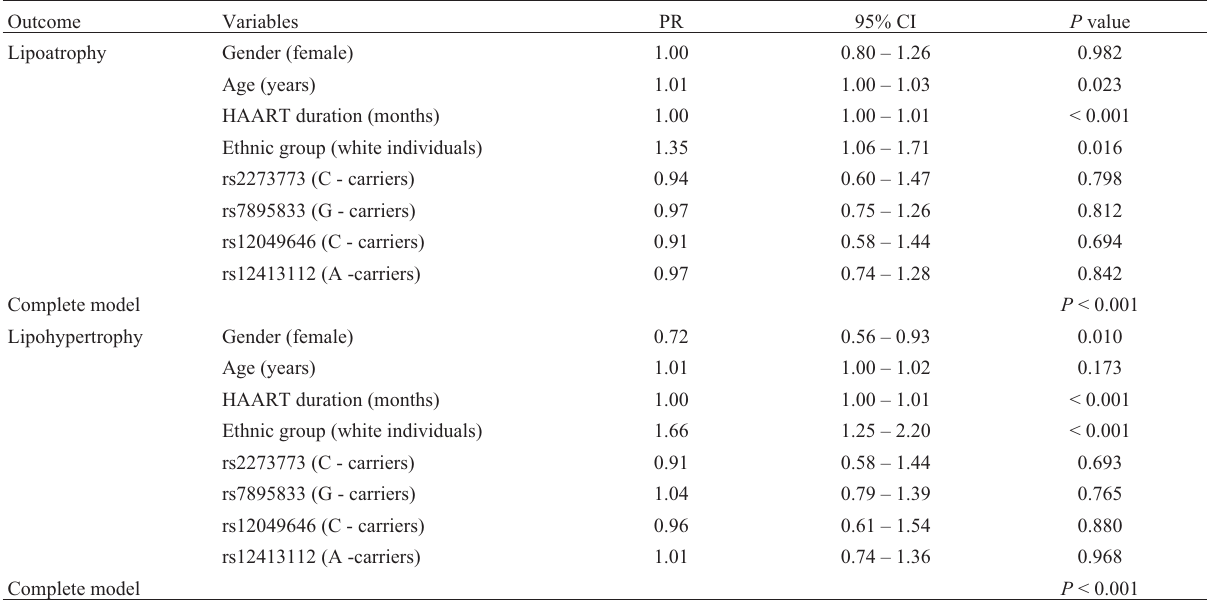
Table6 -PoissonregressionmodelandpredictivevariablesforlipoatrophyandlipohypertrophydevelopmentinHIV-infectedindividualsonHAART.